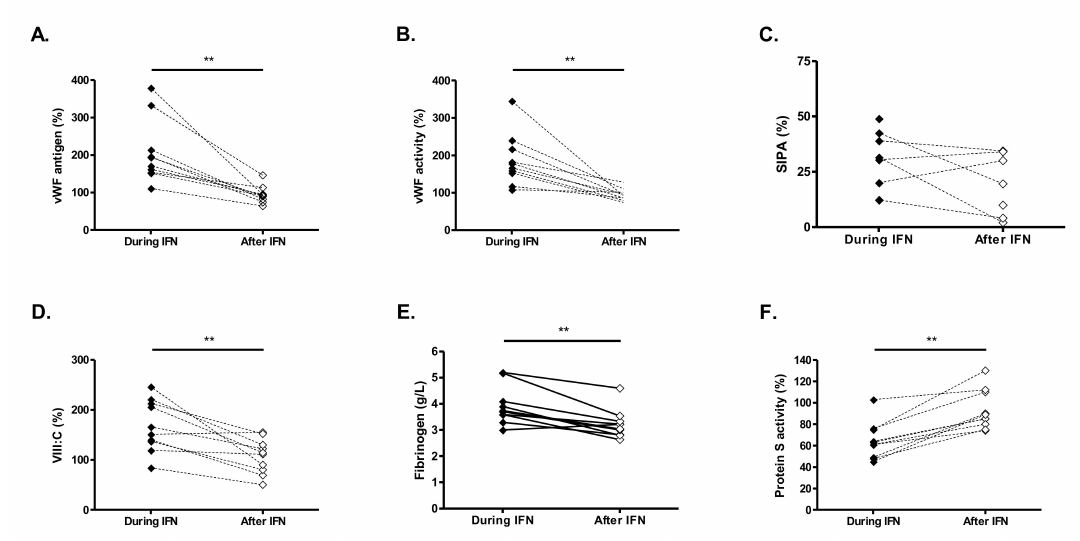
Figure 4. von Willebrand factor antigen ( A ), von Willebrand factor activity ( B ), platelet aggregation induced by high shear at 4000s − 1 (SIPA, C ), VIII:C ( D ) fibrinogen ( E ) and protein S activity ( F ) during IFN treatment and after IFN discontinuation in 10 patients. Comparison between the 2 groups was performed using Wilcoxon matched pairs test. ** p <